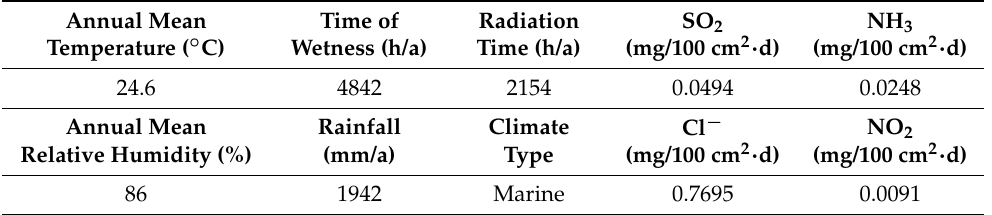
Table 3. Environmental factor data of the Wanning Outdoor Exposure Test Station.